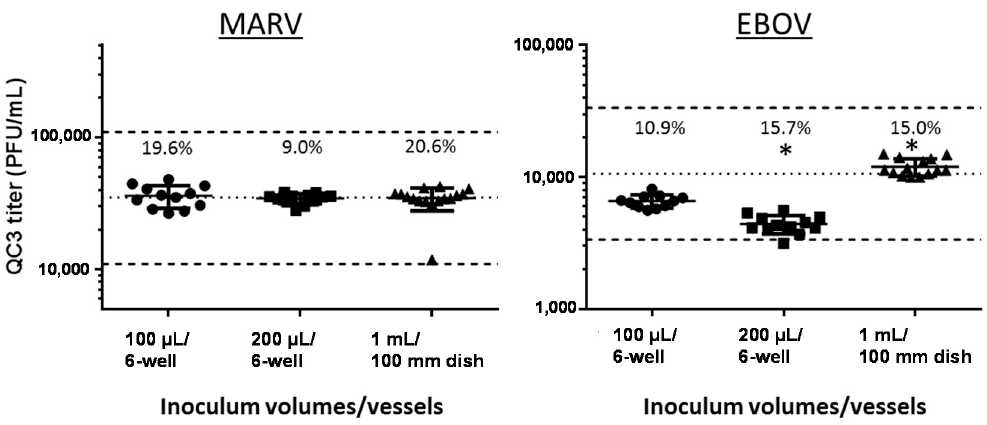
Figure 5. Various inoculum volumes and tissue culture vessels are suitable for use in the validated assay. The individual titers, averages, %CVs and standard deviations for n = up to 15 six-well plates or 100-mm dishes are presented for inoculum volumes of 100 µ L (circles), 200 µ L (squares) and 1 mL (triangles) for MARV and EBOV validation data. * Indicates statistical significance from the 100- µ L group (Student’s t -test, p < 0.01). The central dotted line in the graphs represents the nominal titer for QC3 for MARV and EBOV, respectively. The dotted lines above and below the central line represent ±0.5 log 10 for the nominal QC3 titer and the boundaries into which 80% of the titers must fall to pass the accuracy criterion in this assay. The QC3 titers that the dotted lines represent are presented in Tables 1 and 2 for reference.